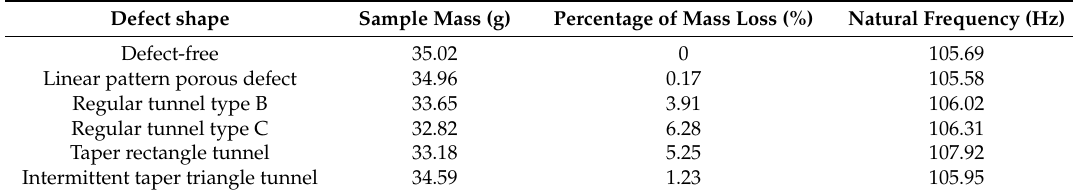
Table 5. Investigated defect types and properties with corresponding frequencies.